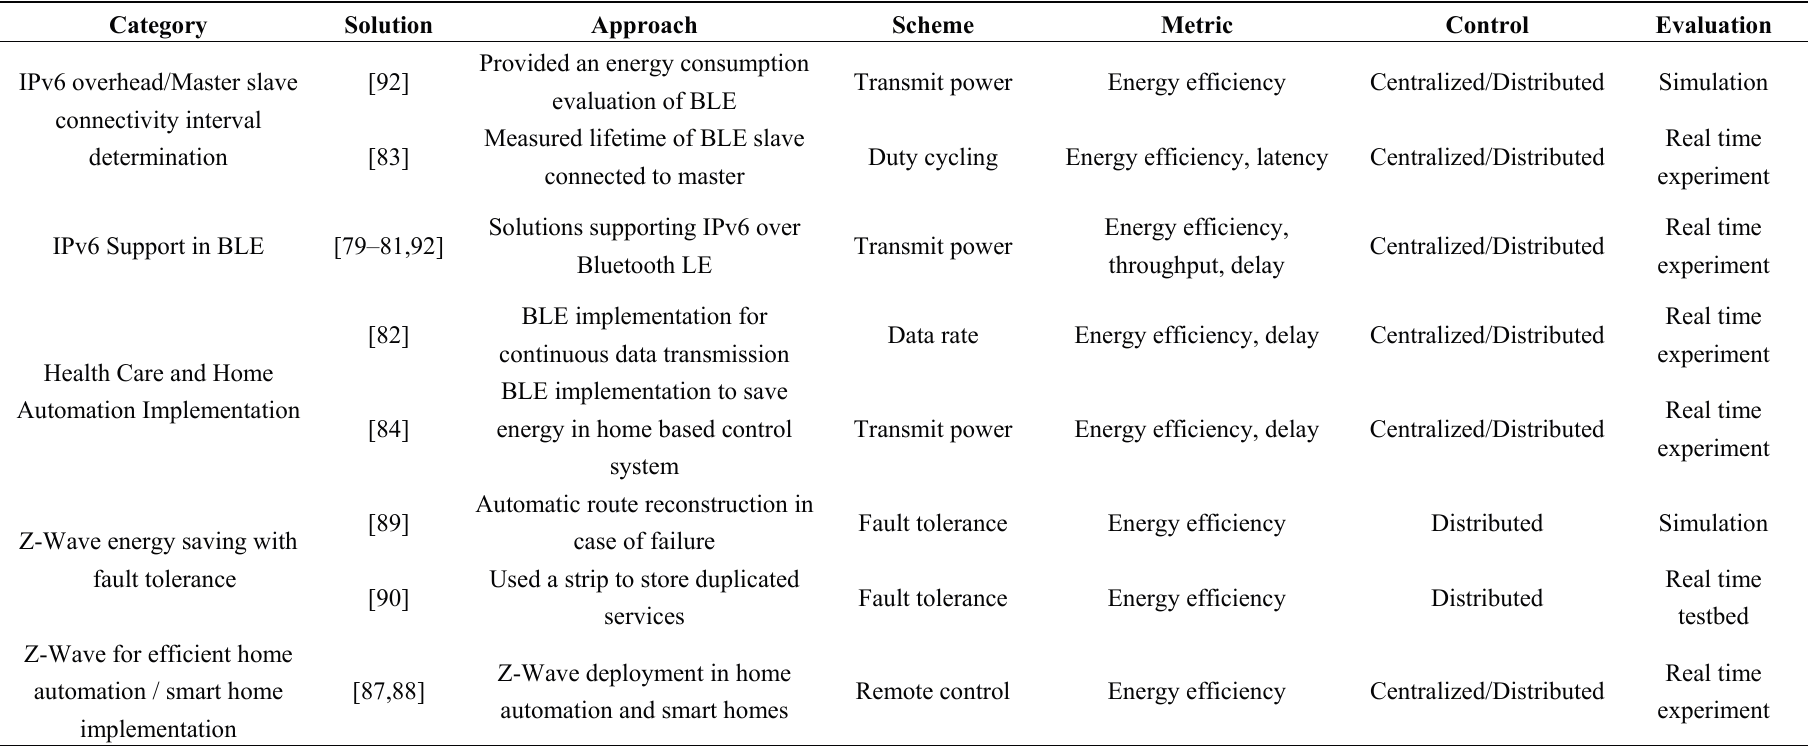
Table 3. Energy conserving solutions for WPAN-based